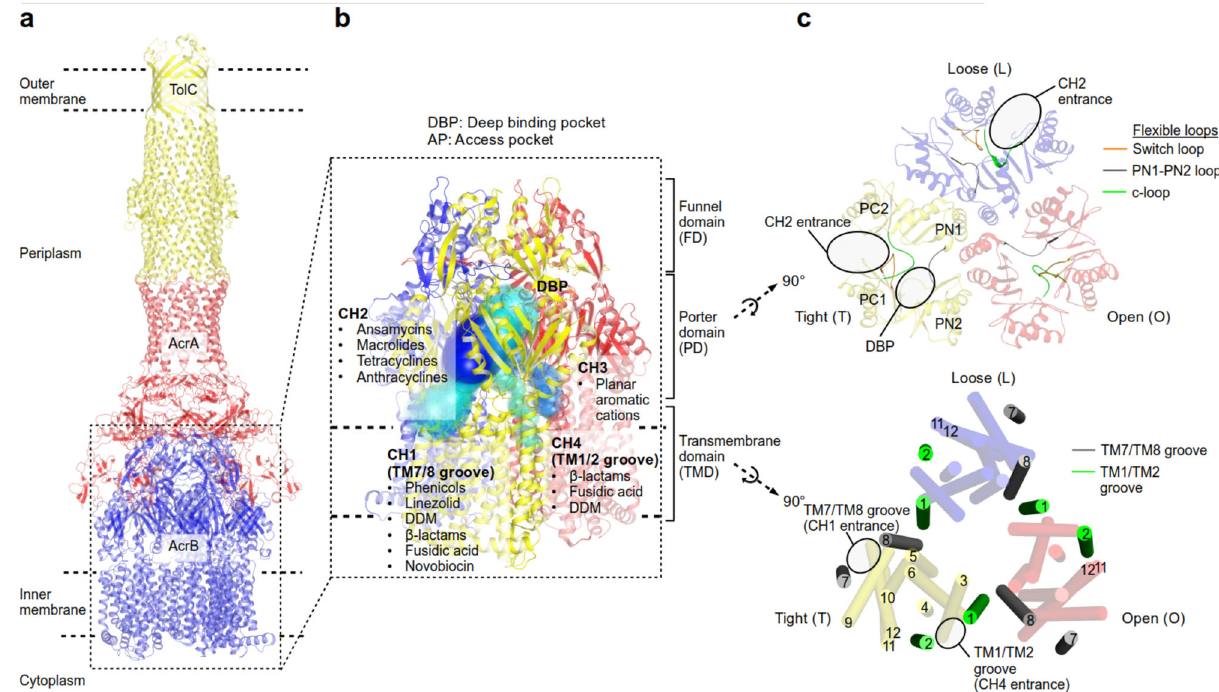
Fig. 1 Visualization of the AcrB channel CH1 – CH4. a AcrAB-TolC tripartite complex. b Putative AcrB drug transport pathways (CH1 – 4) and substrate preferences of each channels. c Top view from the periplasm on the AcrB porter (upper panel) and transmembrane domain (lower